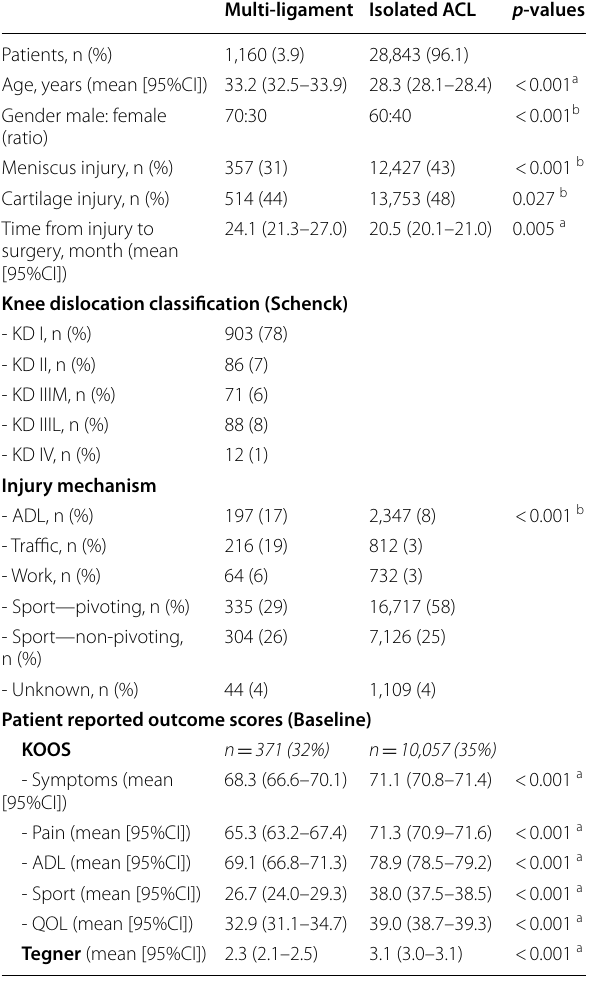
Table 2 Crude and adjusted differences in the KOOS Sport sub-scores of the MLKI group between baseline and 1-year follow-up and the impact of risk factors (gender, age, meniscus and cartilage injury)